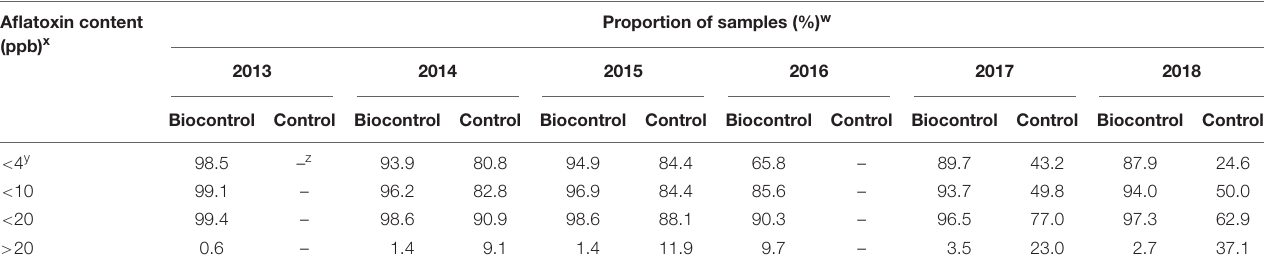
TABLE 9 | Proportion of samples meeting various total aflatoxin standards in freshly harvested maize grain from farmers’ fields that were treated commercially with a biocontrol product in Nigeria during 2013–2018 and from control fields in nearby locations that did not apply the product. Aflatoxin content (ppb)